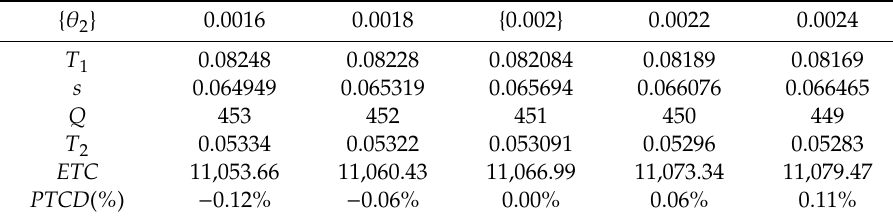
Table 4. Sensitivity analysis when defective rate after inspection changes.